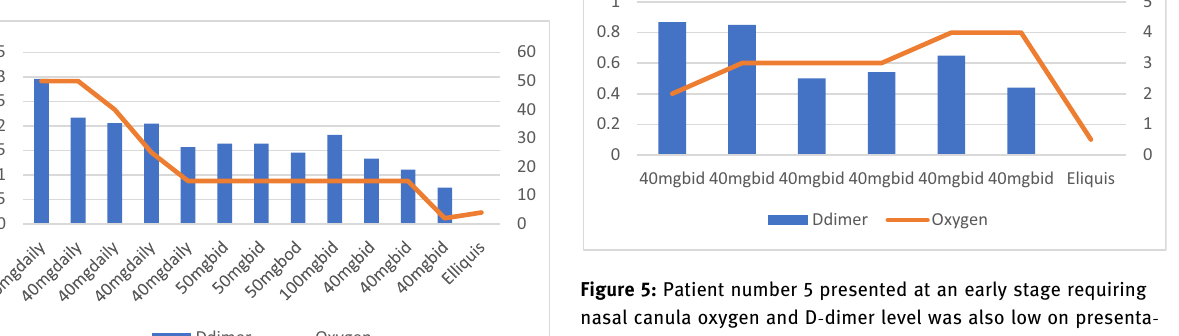
Figure 5: Patient number 5 presented at an early stage requiring nasal canula oxygen and D - dimer level was also low on presenta - tion. The fi gure demonstrates that increase or decrease in D - dimer trends is associated with increasing and decreasing trends of oxygen requirements. This patient was treated with intermediate dose of Enoxaparin ( 40 mg SubQ BID )